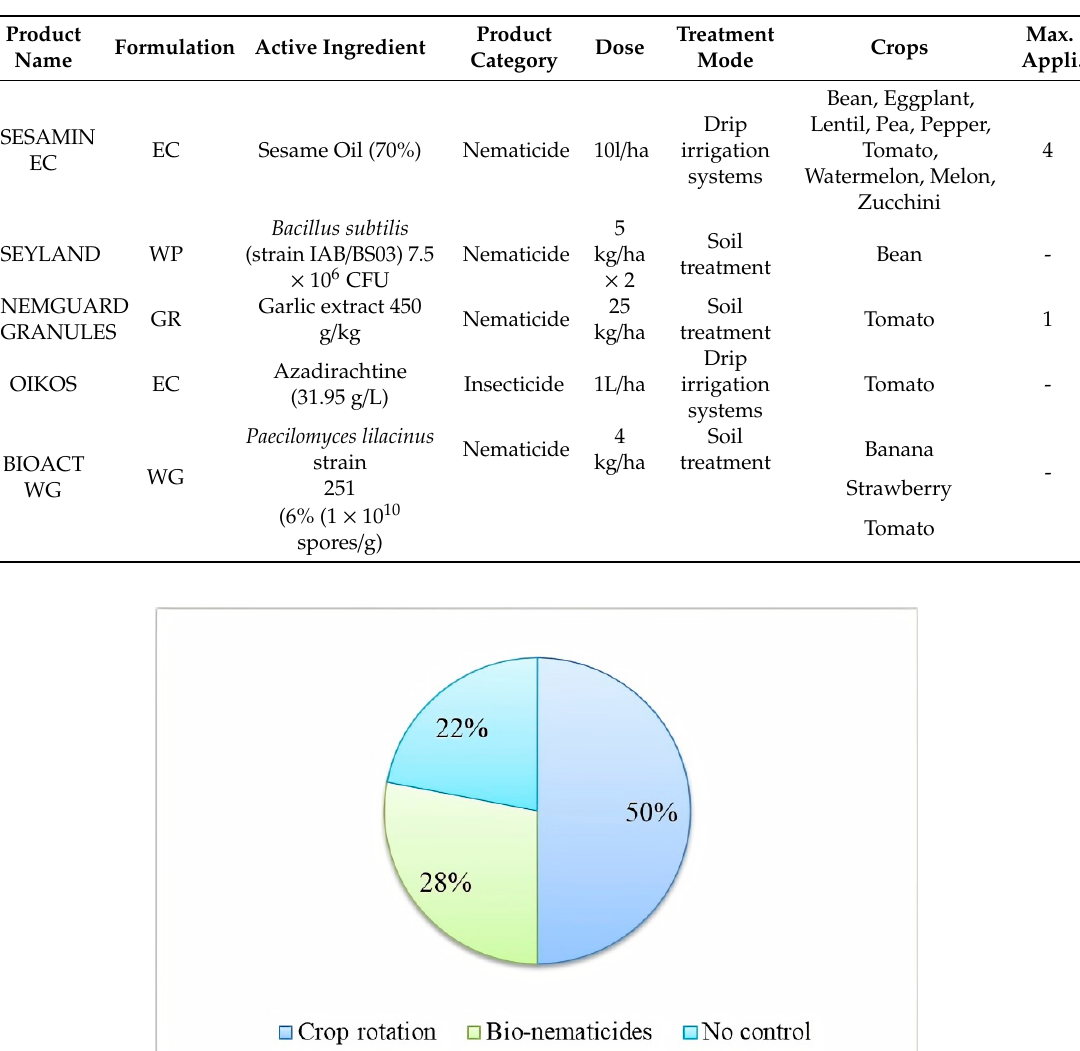
Table 7. Product name, active ingredient, mode of treatment, and application rate of biological nematicides used in Morocco.